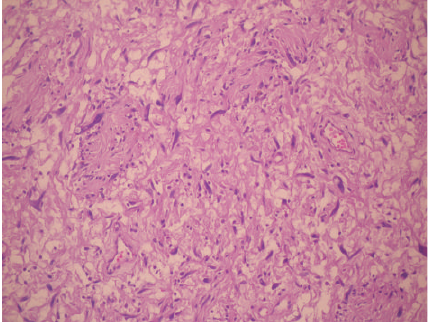
Figure 5: Operative view after sternotomy and preserving nervus vagus; huge mass occupying aortic arch.